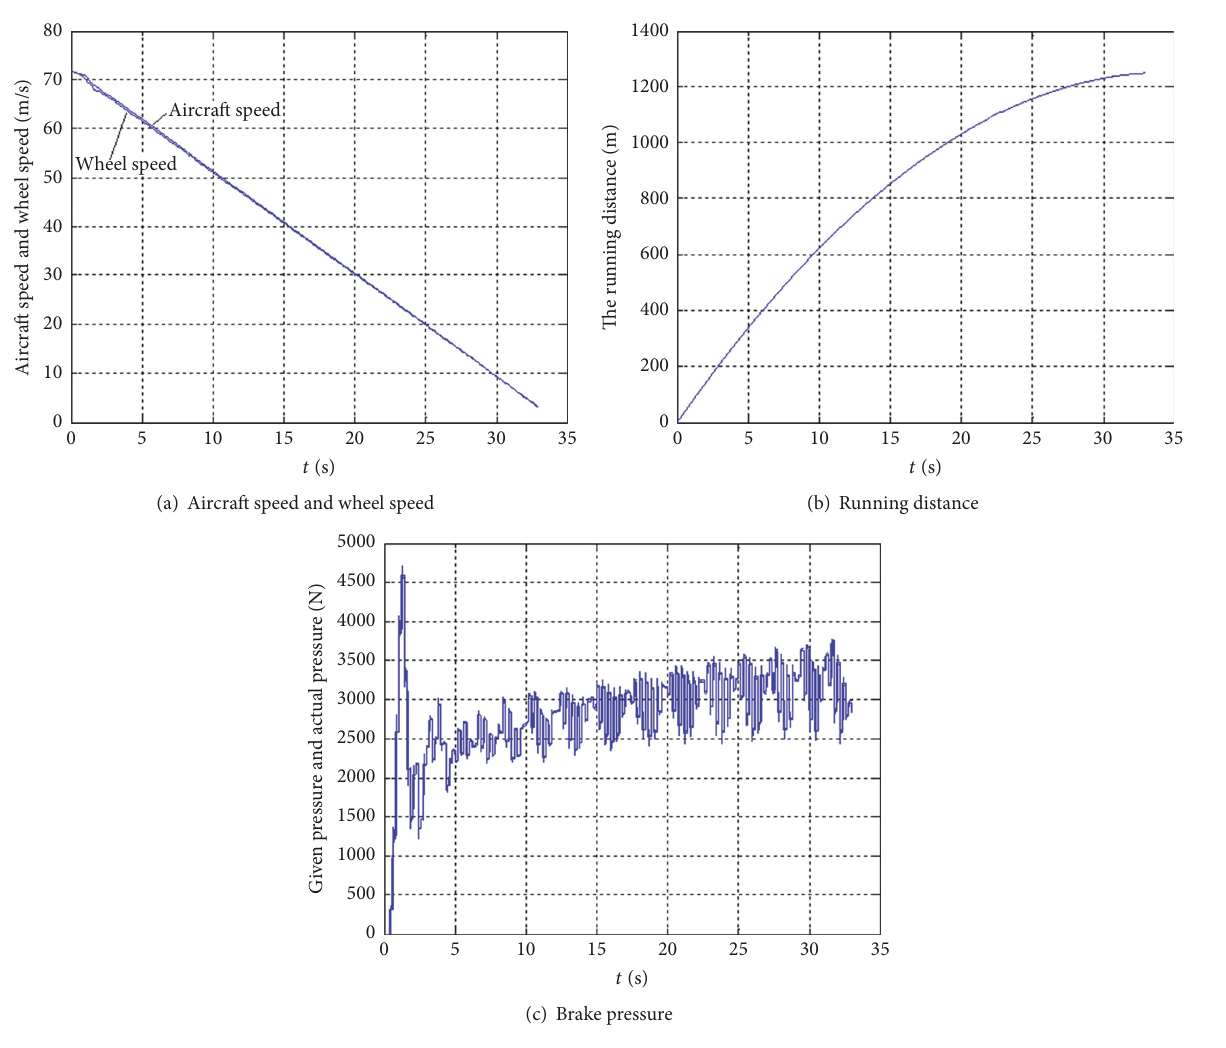
Figure 12: Simulation results when deceleration rate is